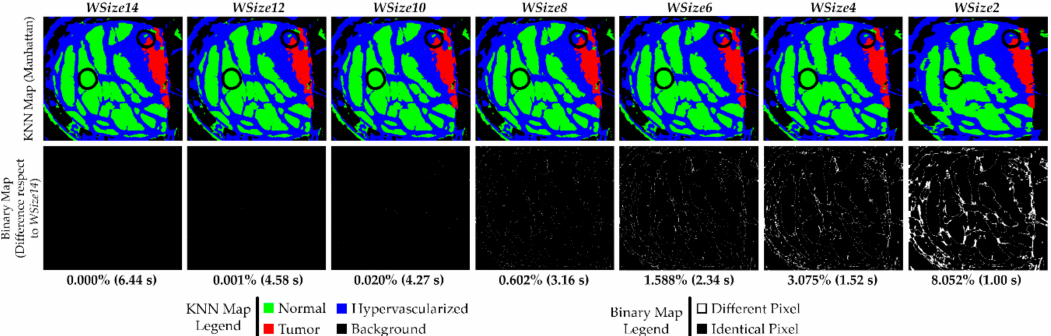
Figure 11. Results of the KNN filtering algorithm obtained from the P2C1 image using the Manhattan distance. The first row shows the filtered classification maps generated using different window sizes. The second row presents the binary maps where the pixel differences between the current generated map and the WSize14 . In addition, the percentage of differences and the execution time results are